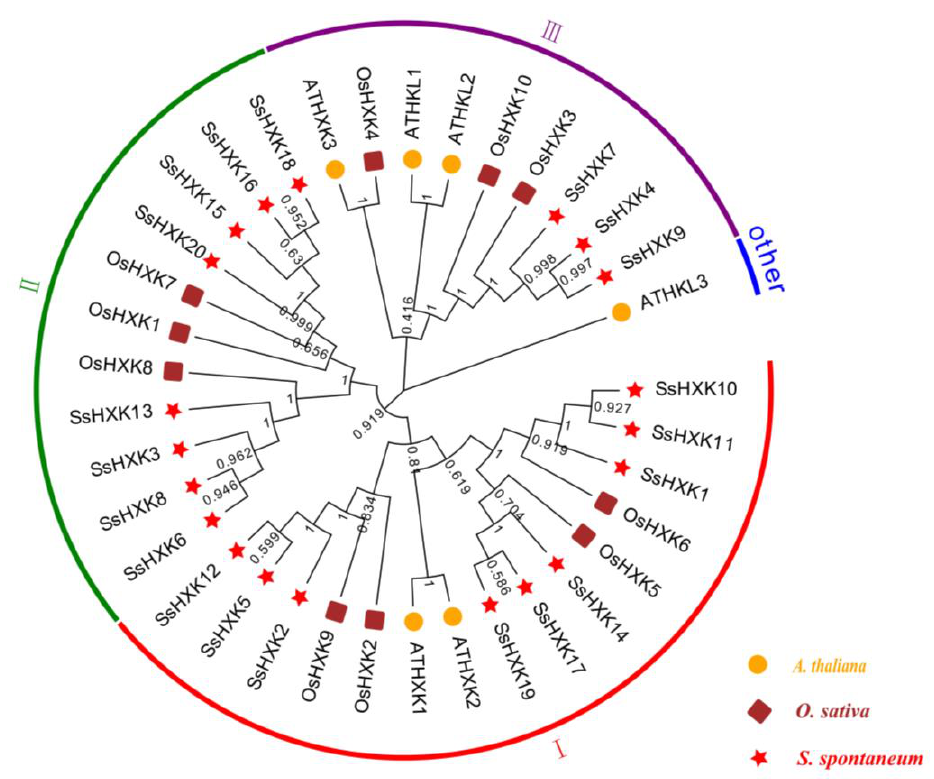
Figure 2. Phylogenetic analysis of the SsHXK proteins. The neighbor-joining tree (N-J tree, 1000 boosted replicates) were constructed using MEGA X. Proteins from AP85-441( S. spontaneum ), rice ( O. sativa ) and A. thaliana are represented by stars, squares, and circles, respectively.